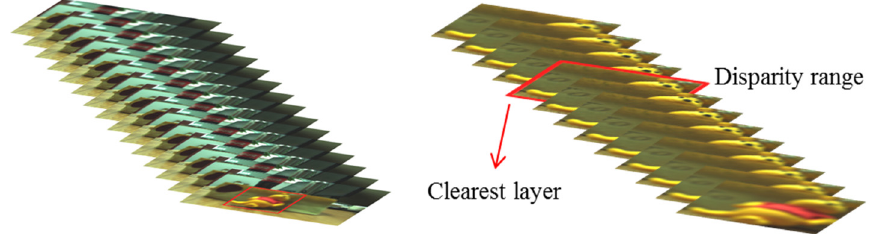
Figure 5. An illustration of depth estimation based on the defocus response of the focal stacks.